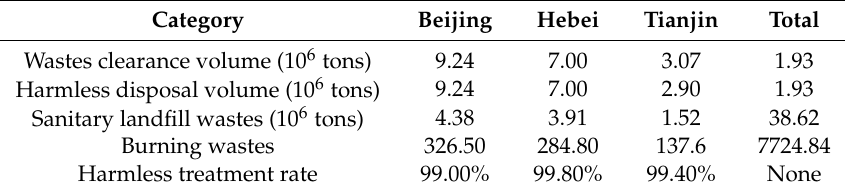
Table 11. Municipal solid waste (MSW) production in 2017 (source: http: // www.stats.gov.cn /